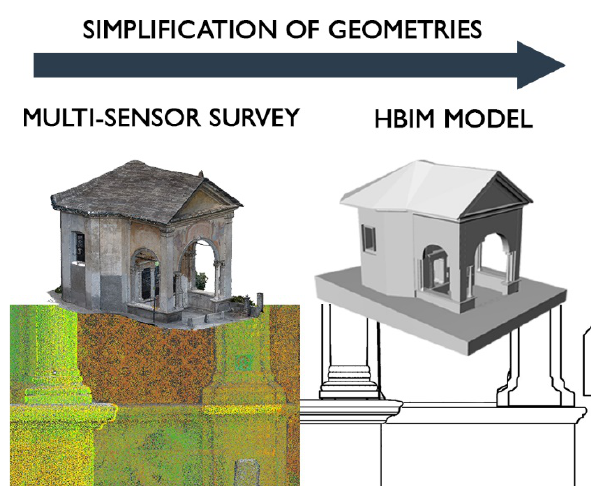
Figure 10: the simplification of HBIM model is an interpretation process from the survey data, which are much higher